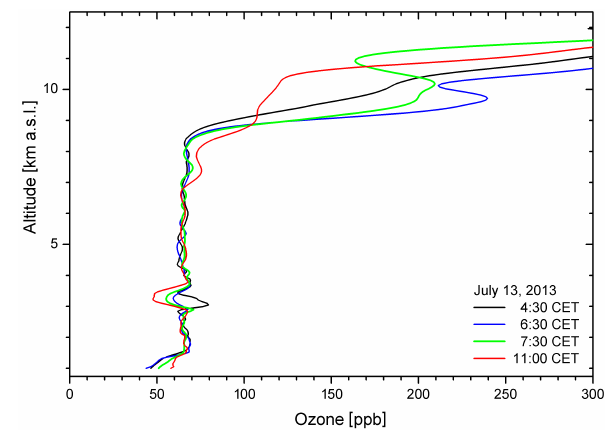
Figure 10. 313nm particle backscatter coefficients for 13 July 2013; on this day almost the entire troposphere was filled with aerosol layers from the Canadian fires.